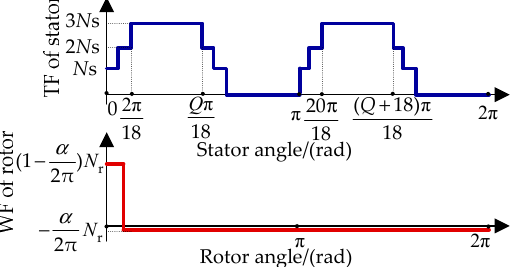
Figure 7. Turn function (TF) and winding function (WF) distribution of stator phase A to rotor loop 1 when 0 ≤ θ m < 2 π /18- α .